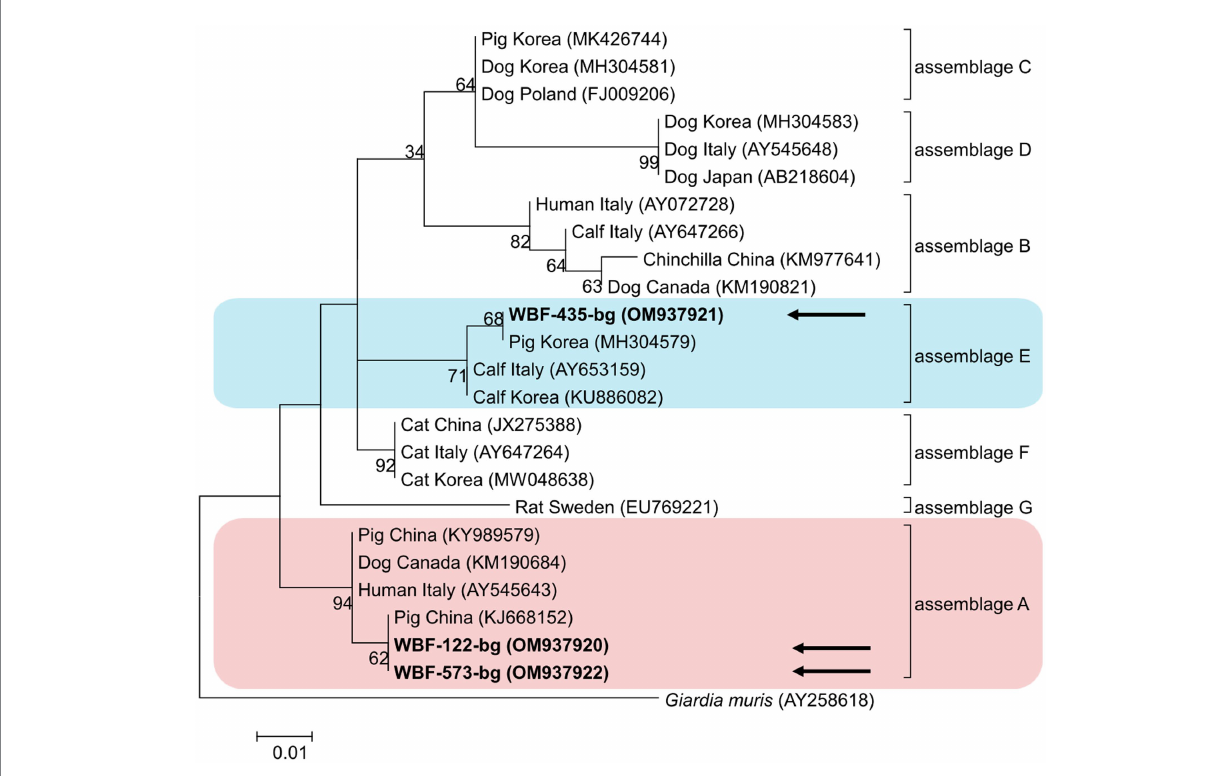
FIGURE 3 Phylogenetic tree of Giardia ( β -giardin) isolated from Korean wild boars. The sequences obtained from the phylogenetic analysis based on the Giardia β -giardin gene are indicated in